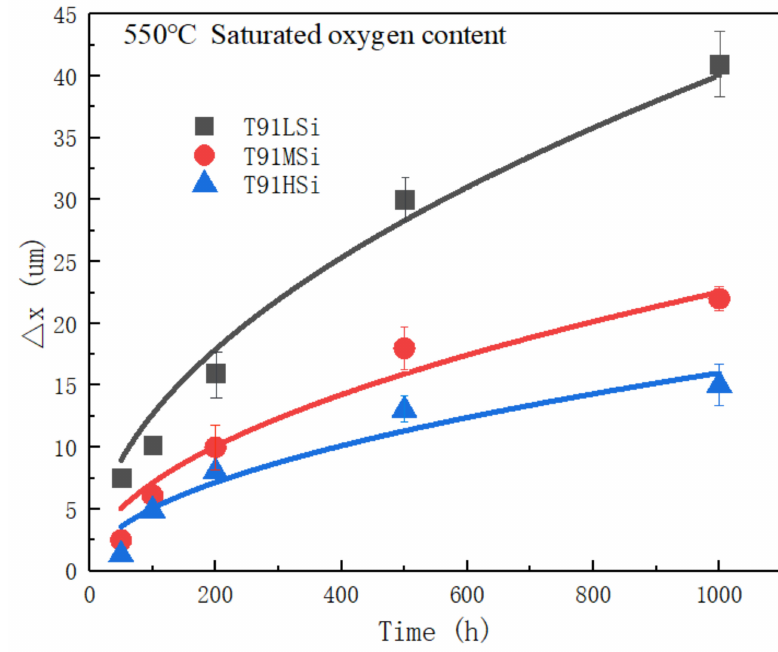
Figure 6. Variation law of oxide film thickness with time static